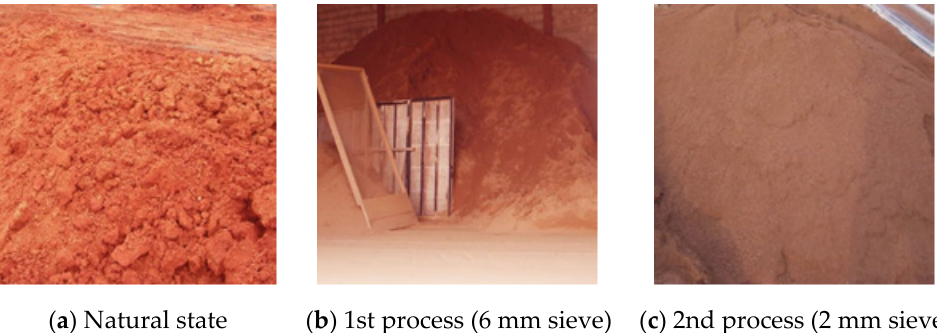
Figure 4. Red clay. Table 1. Chemical compositions of materials.